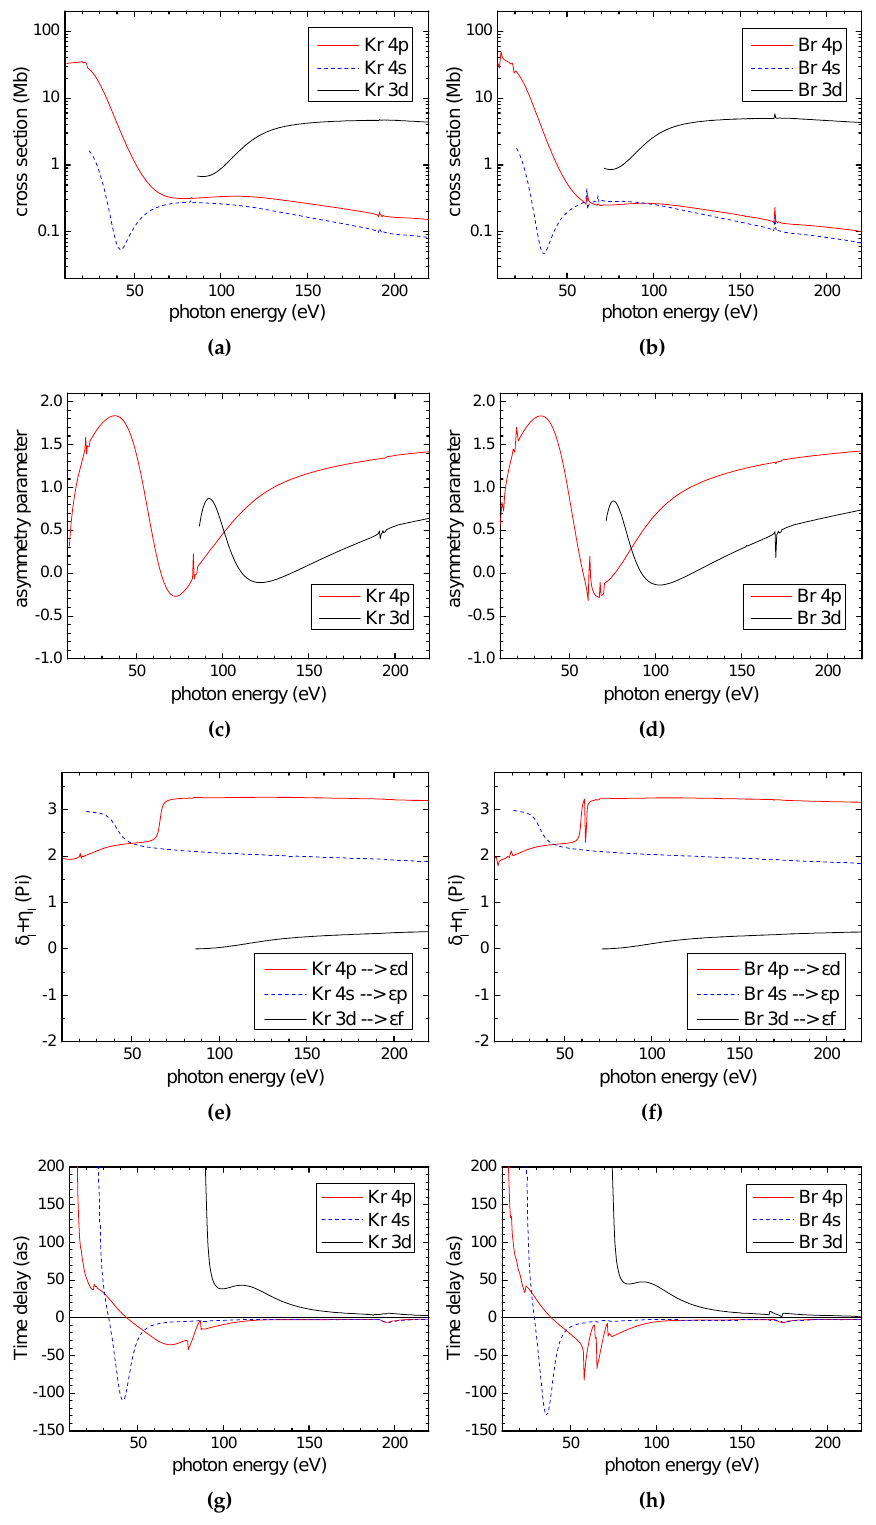
Figure 2. Left to right columns: calculations for krypton ( a , c , e , g ) and bromine ( b , d , f , h ) atoms. Top to bottom rows: partial cross section ( a , b ), asymmetry parameter ( c , d ), short-range plus induced phase shift ( e , f ), and Wigner time delay ( g , h ) for subshells 4 p , 4 s and 3 d